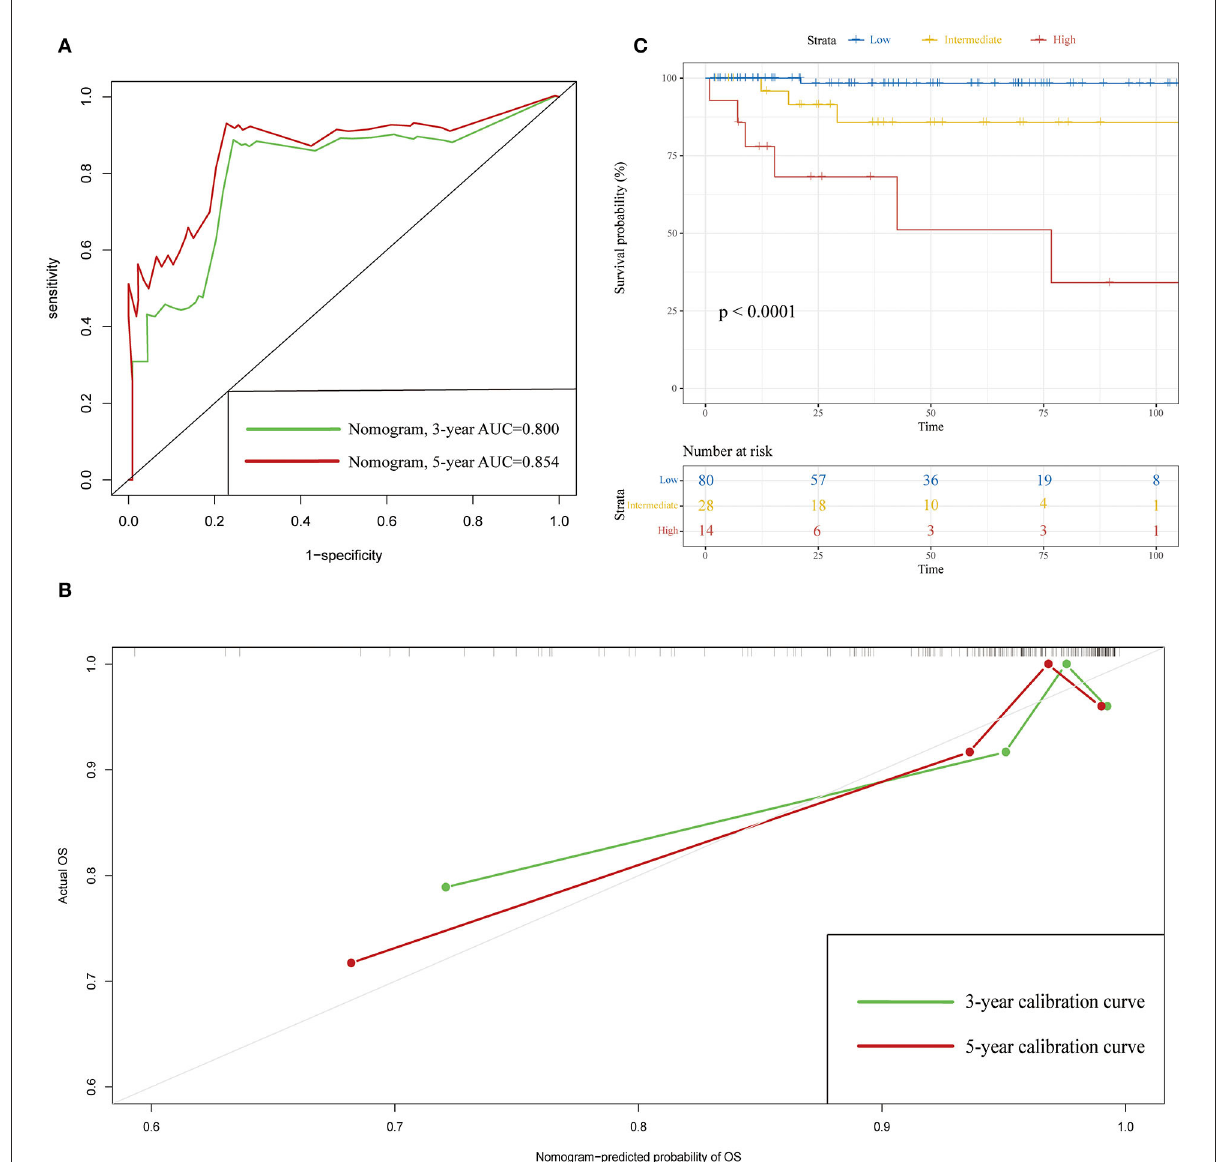
FIGURE7 Validation results in the AHMU-pRCC cohort. (A) ROC curves of 3- and 5-year overall survival. (B) Calibration curves of 3- and 5-year overall survival. (C) Kaplan–Meier curves show the overall survival of patients with papillary renal cell carcinoma after nephrectomy in the low-, intermediate-, and high-risk